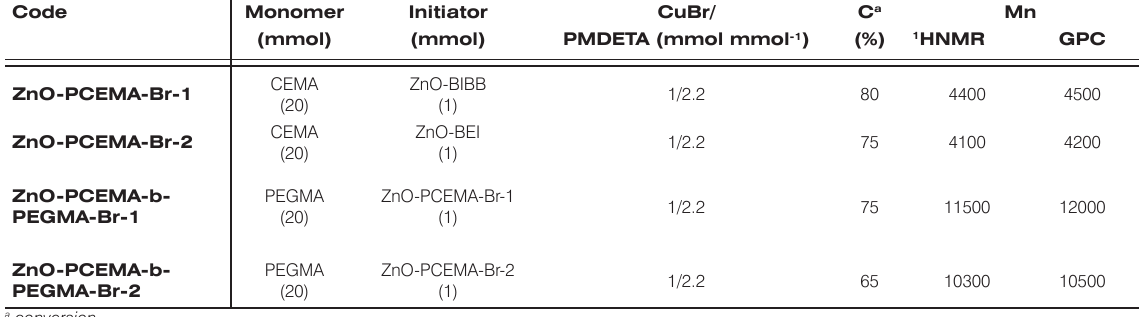
Table 1. The synthesis of